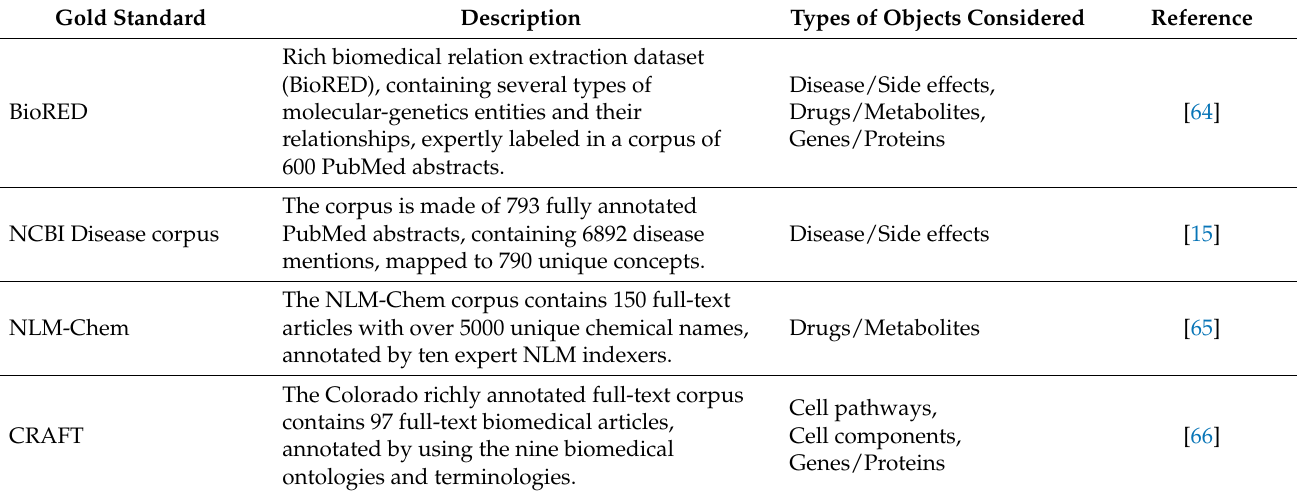
Table 4. List of the well-known gold standards, used for the additional evaluation of the accuracy of the fine-tuned classification